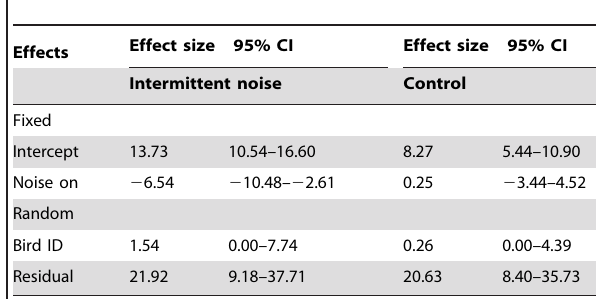
Table 3 Results of a BMM modelling Lundy island house sparrow female provisioning frequencies (visits/hour) at a location intermittently affected by noise and at control nestboxes during the same time periods (two-level factor with noise off as the reference level). Statistically significant fixed effects are indicated in